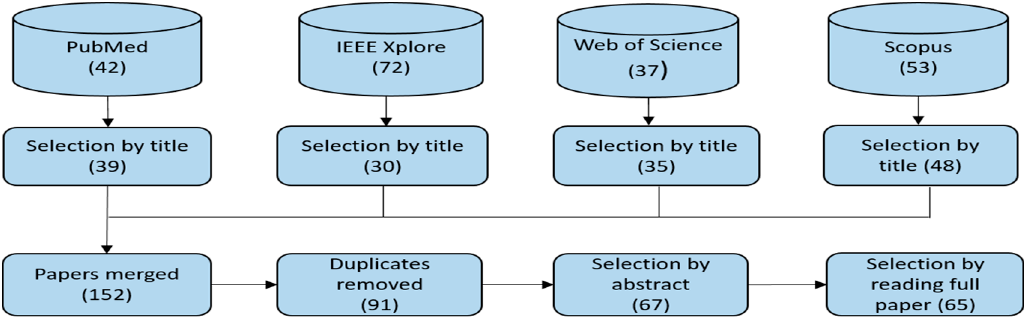
Figure 5. Selection process for the relevant papers. Table 3. List of selected papers.